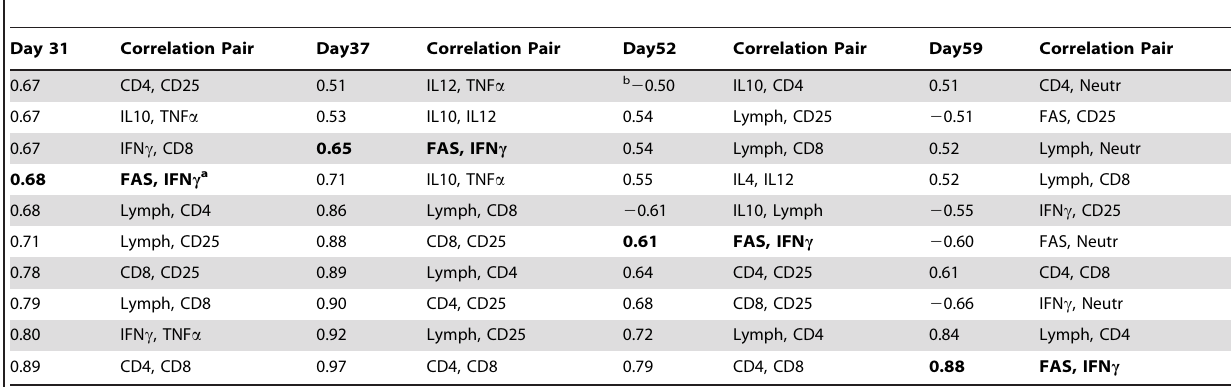
Table 3. Spearman’s coefficients of the ten strongest (absolute) pair-wise correlations between immunological responses for each day of